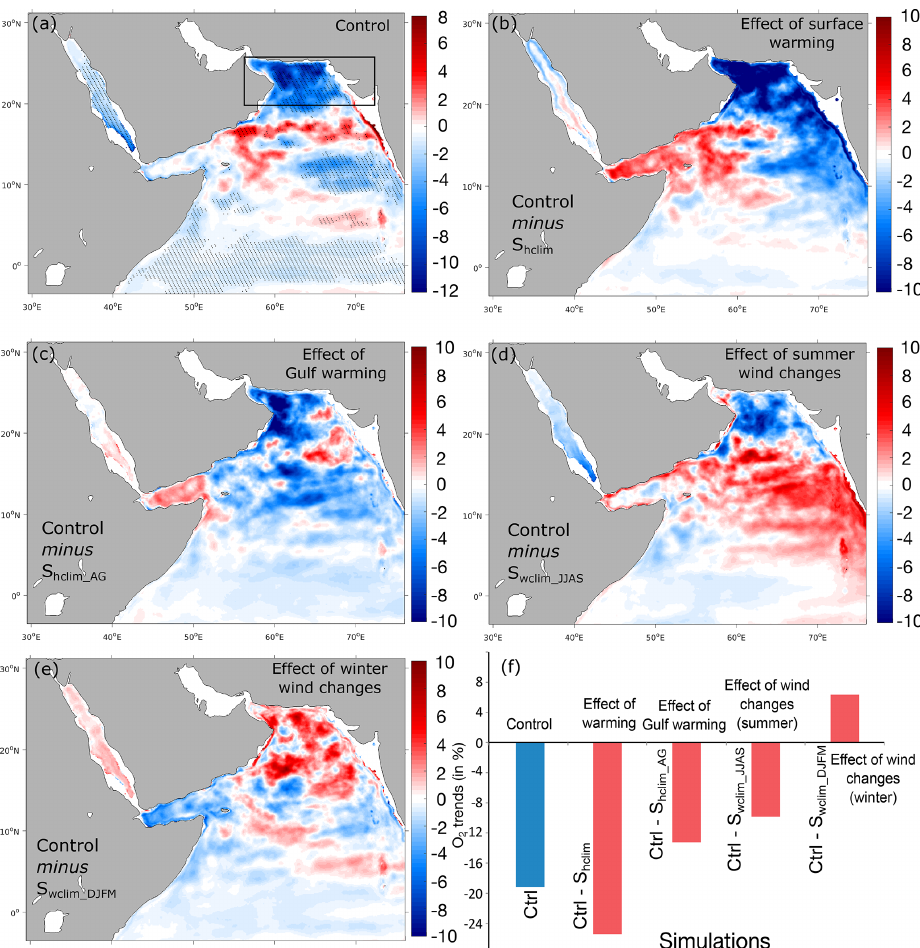
Figure 8. Effects of different atmospheric forcing perturbations on deoxygenation rates. (a) Linear trends in O 2 inventories in the 100– 1000m layer in the control run (in percent per decade). (b–e) Difference in O 2 inventory trends between the control run and the S hclim (i.e., effect of warming), S hclim_AG (i.e., effect of Gulf warming), S wclim_JJAS (i.e., effect of summer wind intensification) and S wclim_DJFM (i.e., effect of winter wind changes) sensitivity simulations in the 100–1000m layer (in percent per decade). (f) Difference in O 2 inventory trends in the northern AS box between the control and the different sensitivity simulations (in percent of the mean O 2 inventory over the 1982–2010